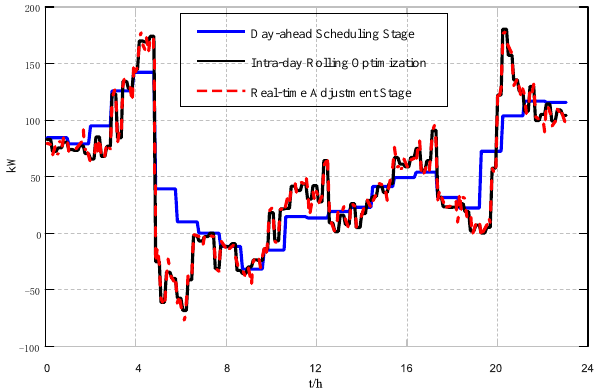
Figure 7. Battery charge and discharge power at multiple time scales.